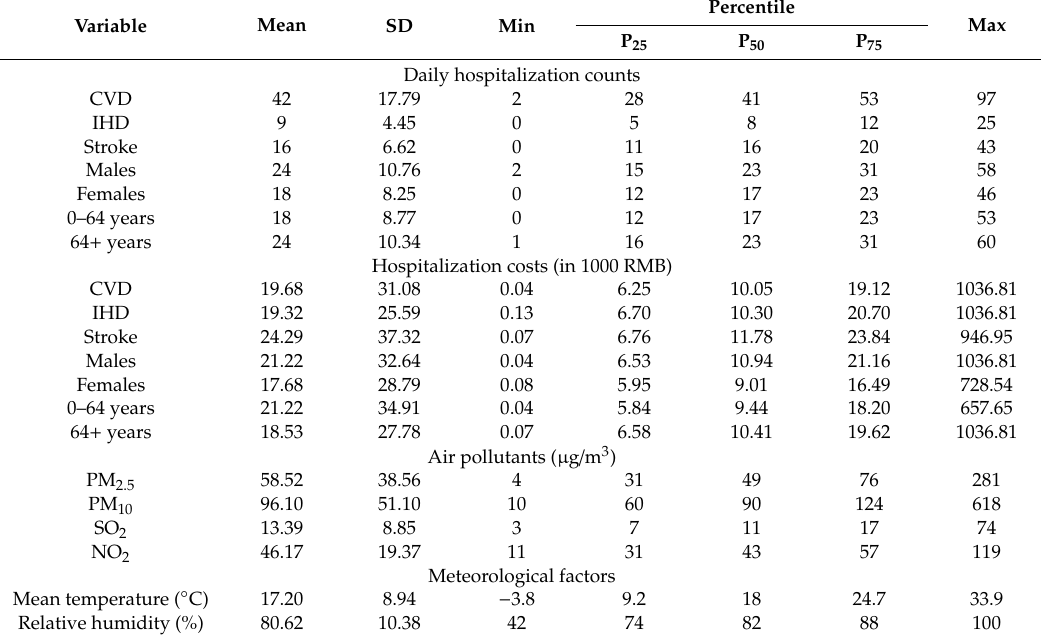
Table 1. Summary statistics of daily hospitalization counts, hospitalization costs, air pollutant concentration and meteorological factors in Wuhan, China, from